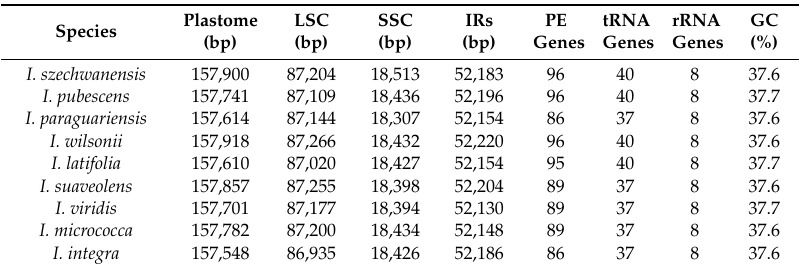
Table 3. List of plastid genome features in Ilex